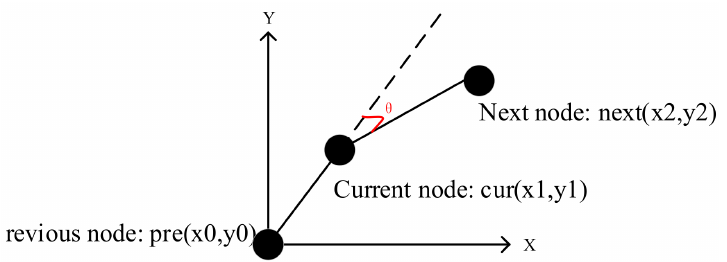
Figure 7. Calculation model of steering cost model angle.